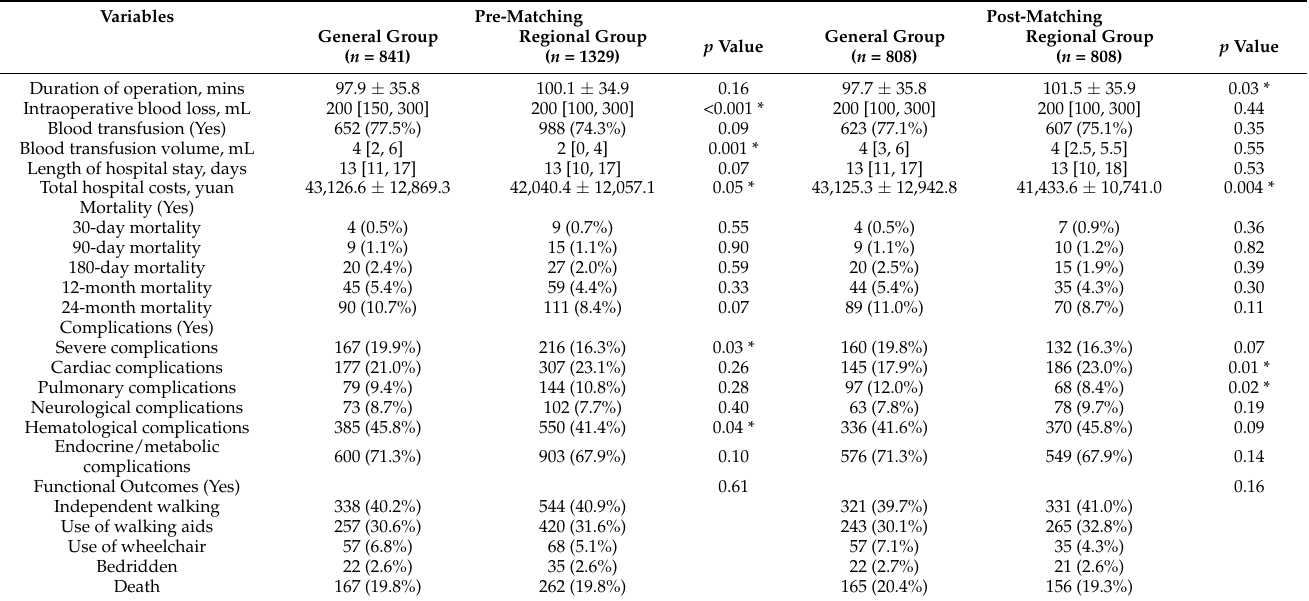
Table 2. Patient outcomes analyses before and after propensity score